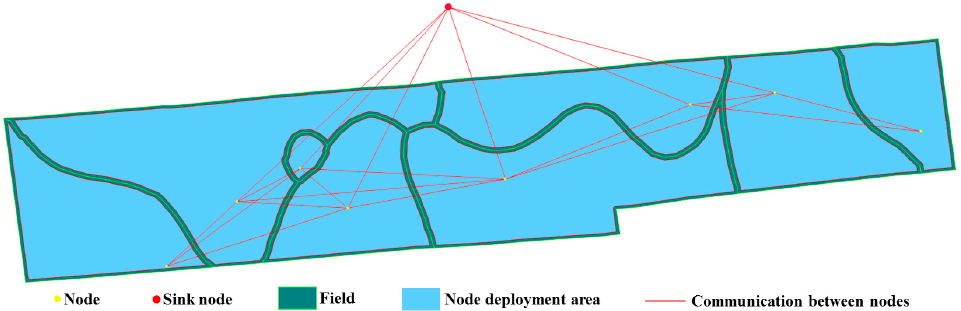
Figure 14. The WSN deployment on irregular farmland located in Rugao, Jiangsu Province, China. The communication distance is 200 m, and the connectivity is 2.